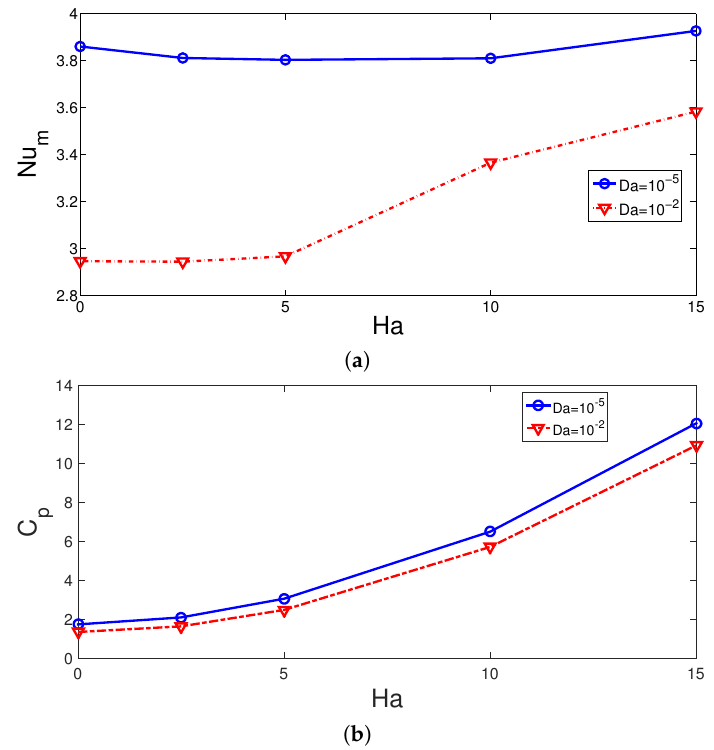
Figure 10. Average Nu and pressure coefficient variations for different MaF strengths at two different PL permeabilities (Re = 250, Rew = 1000, ax = 0.25 ap, N = 4).